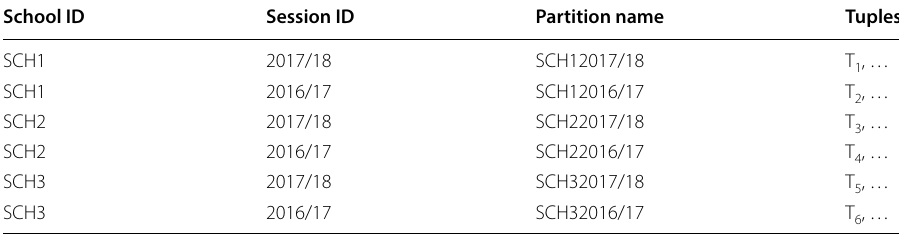
Table 2 Big data partitions of assessment scores School